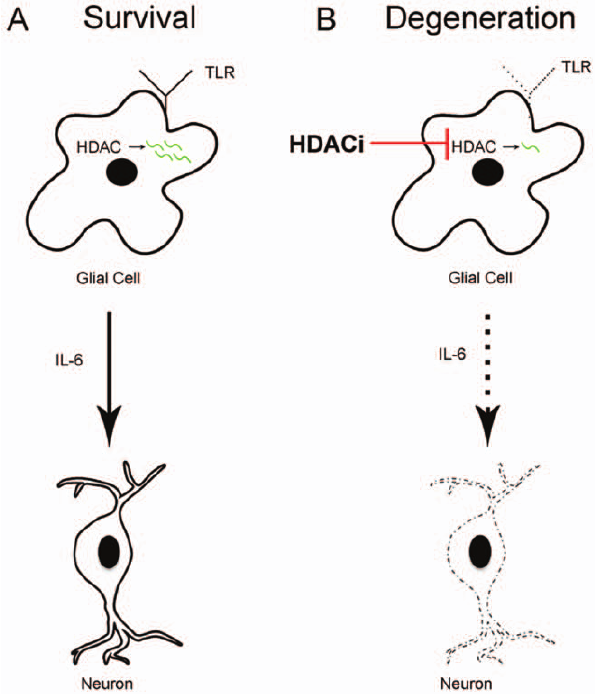
Figure 12. A model of HDAC and TLR signaling in midbrain neuronal survival. A model depicting one possible role of HDACs in mediating neuronal survival, in this case cell non-autonomously. (A) HDAC function in glial cells promotes the stability of mRNA or facilitates translation during the expression of TLR4 and other innate immune related factors. This allows glial cells to respond to TLR signaling and release downstream effectors, such as IL-6 and other factors. These secreted cytokines mediate neuronal survival. (B) HDAC inhibition would lead to hyperacetylation of histones and other proteins, the latter of which might negatively impact mRNA stability or translation of innate immune related genes, such as TLR4. The result is a decrease in overall TLR signaling and release of IL-6 and other cytokines leading to neuronal cell death.